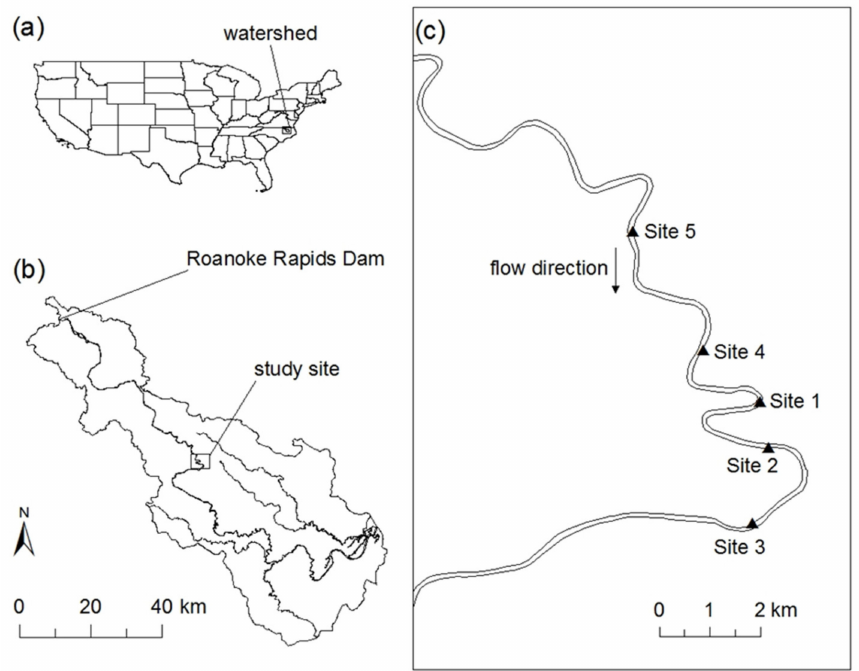
Figure 1. Field study site location showing ( a ) the United States and the location of the lower Roanoke River watershed in North Carolina; ( b ) the Roanoke River watershed below the Roanoke Rapids Dam; and ( c ) the study sites on the lower Roanoke